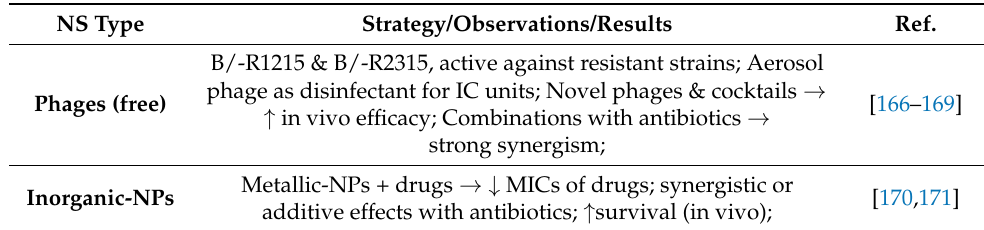
Table 7. Nanosystems for treatment of CRAB